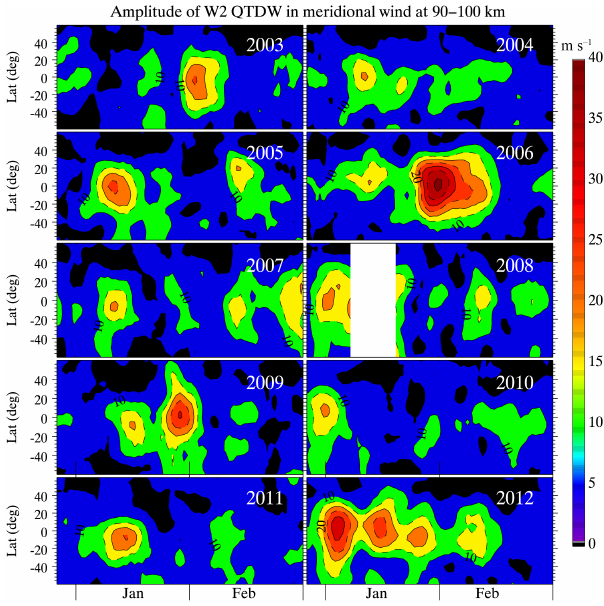
Figure 3. The same as Fig. 2 but for the wave number 2